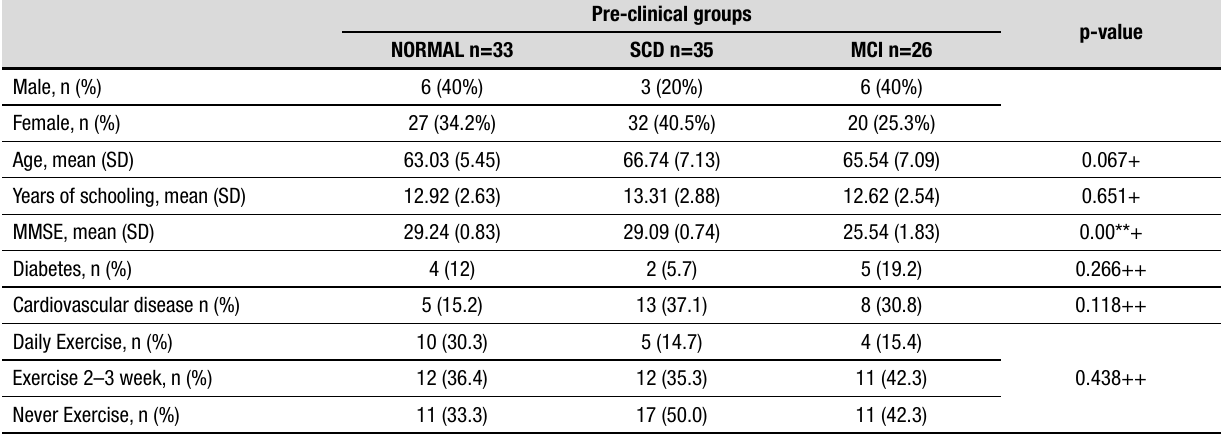
Table 1. Sociodemographic and clinical data of preclinical groups (n=94).